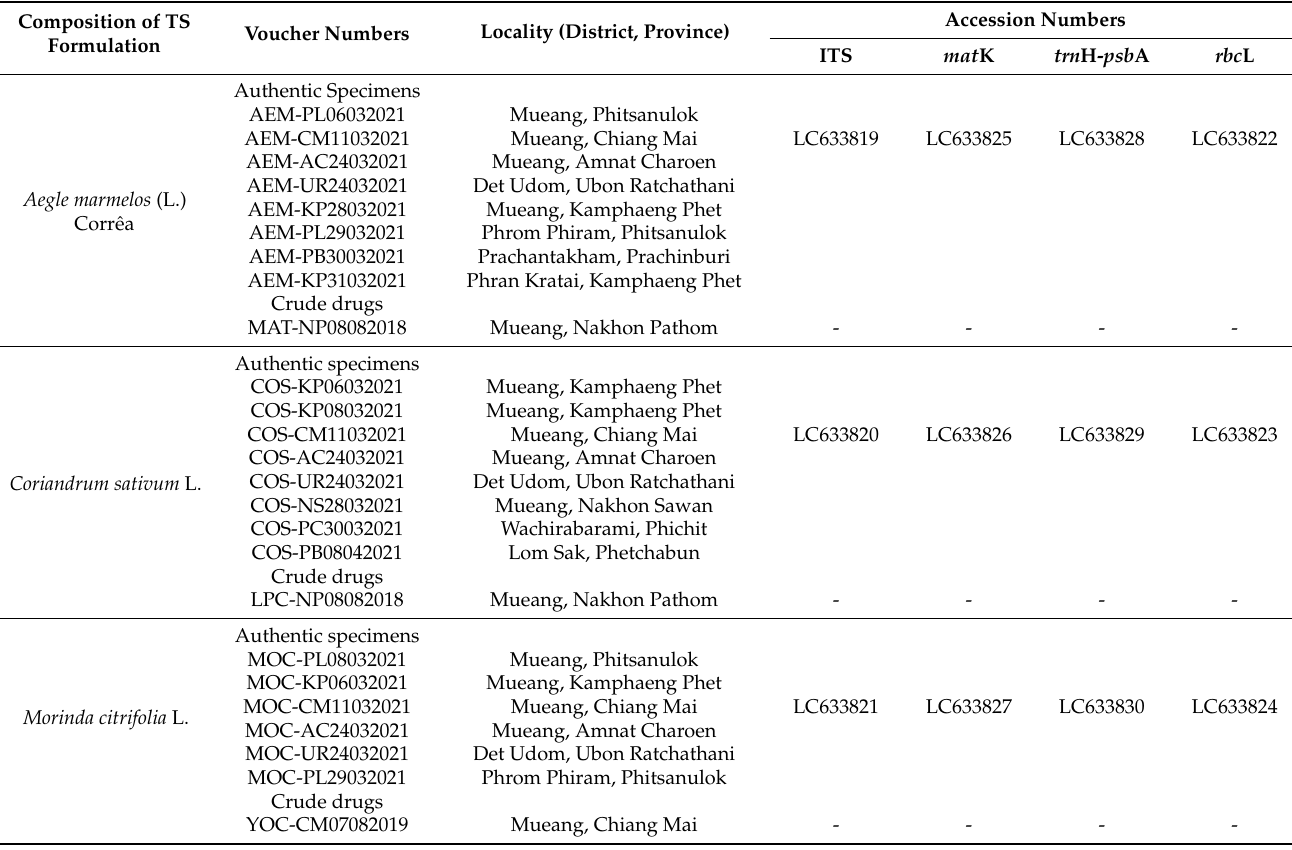
Table 2. List of collected samples for generation of core DNA barcodes of the compositions in the TS formulation. Composition of TS Formulation